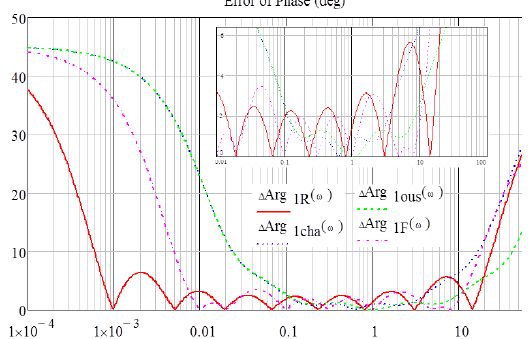
Fig. 12: Errors of the phase